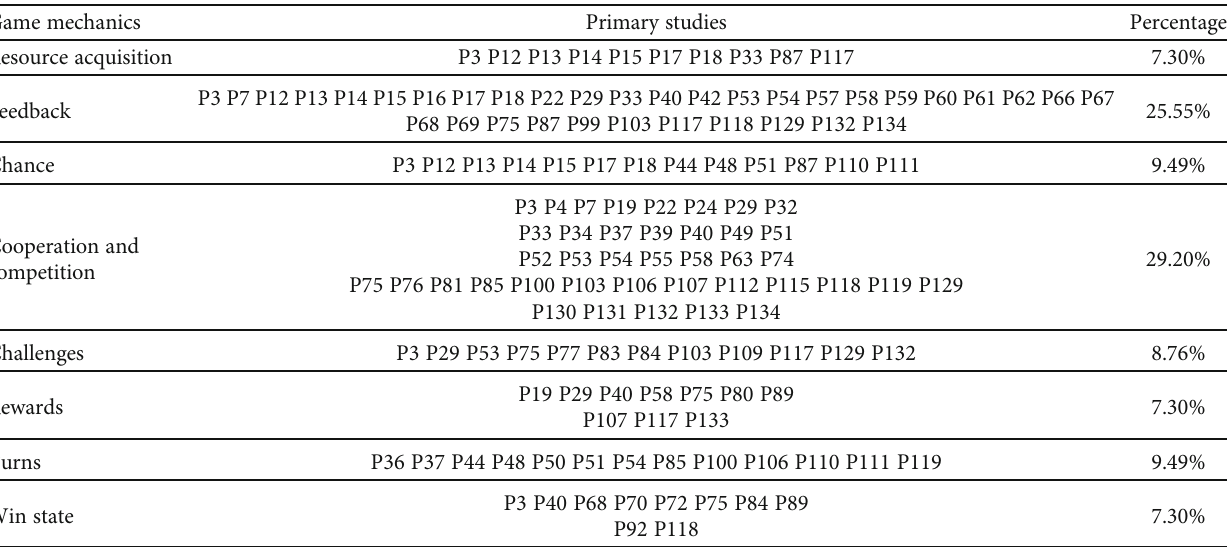
Table 13: Mechanics per primary